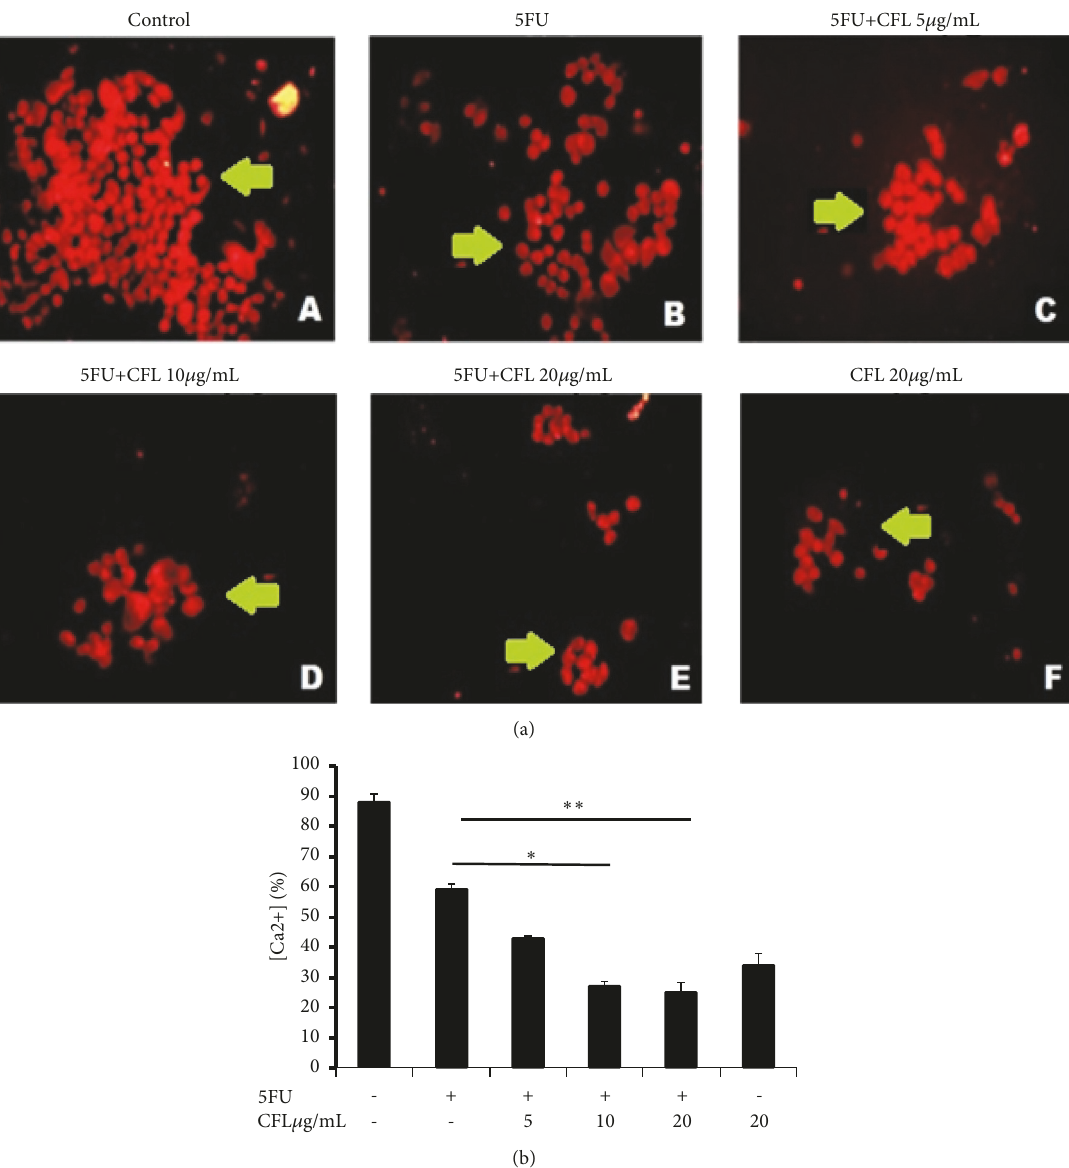
Figure 3: The combination therapy of CFL with 5-fluorouracil reduced the expressions of Ca 2+ intracellular level in HT-29 cells. (A) Control group. (B) Group was treated with 5FU only. (C), (D), and (E) HT-29 cells were treated with CFL 5, 10, and 20 𝜇 g/mL, respectively, after 5-fluorouracil, (F) HT-29 cells were treated with CFL only. Green arrow: Ca 2+ intracellular positive cell. All images were magnified at representative 4 independent experiments (G). Number of Ca 2+ intracellular positive cells. The result of [iCa 2+ ] expression also showed that combination groups have lower expression than 5FU only group, respectively (p < 0.05; p < 0.05; p < 0.05). ∗ p-value < 0.05; ∗∗ p-value <